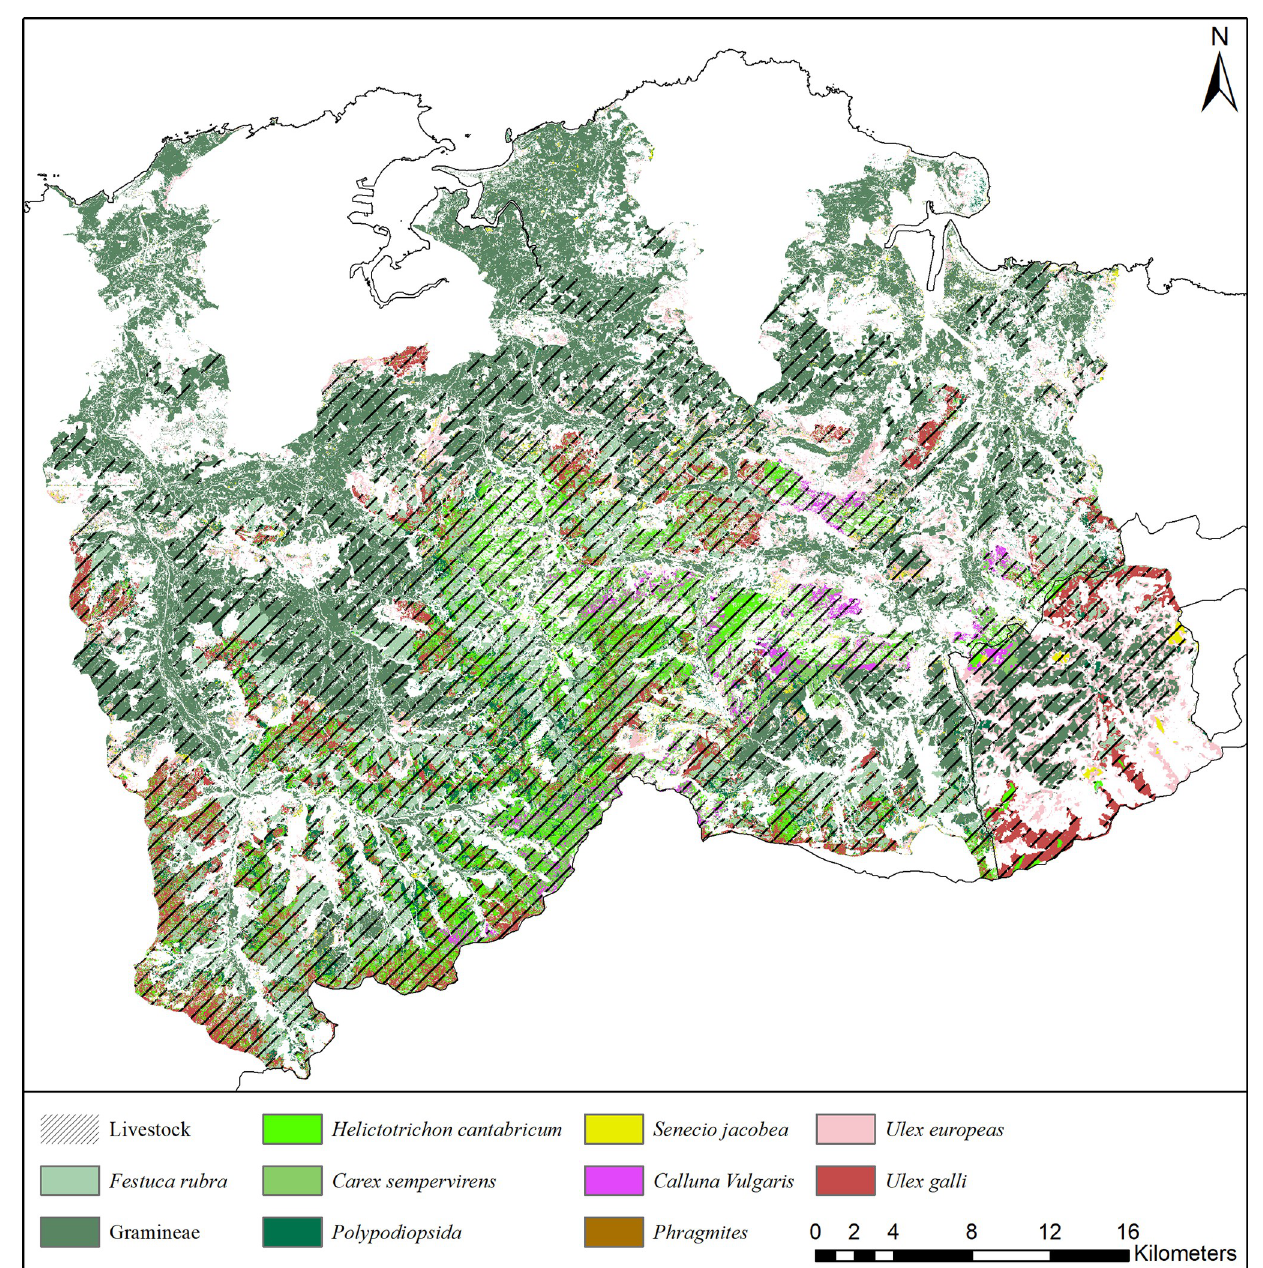
Fig 2. Distribution of livestock and pastureland types in the case study. Reprinted from [69] under a CC BY license, with permission from GDAM (Global Administrative Areas), original copyright 2018–2021.